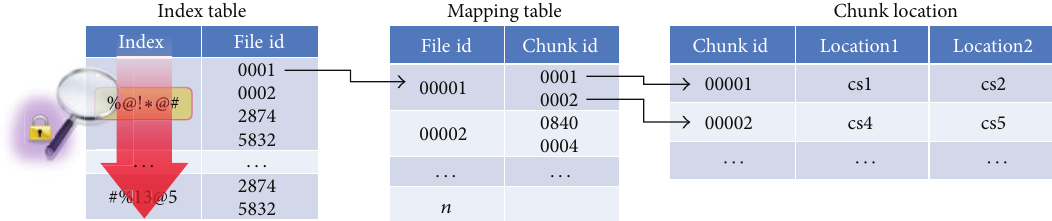
Figure 1: Existing index structure of PRES.